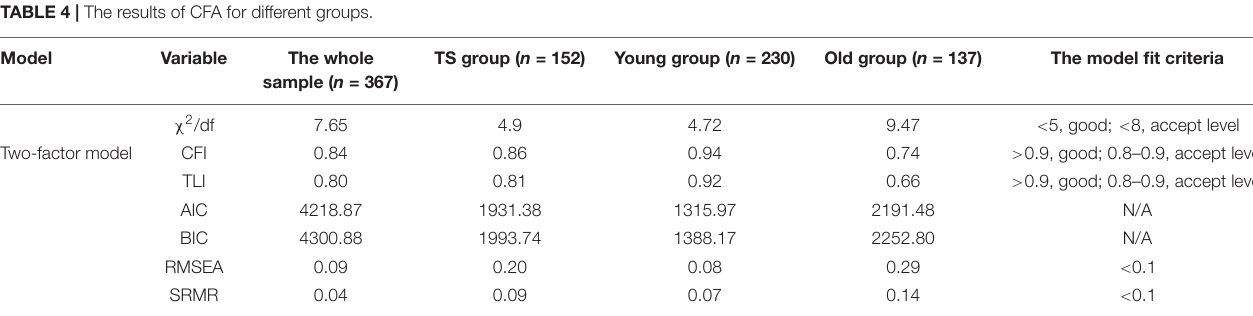
FIGURE 2 | Confirmatory factor analysis of CY-BOCS in the younger and older adolescent groups. CY-BOCS, Children’s Yale–Brown Obsessive–Compulsive Scale. TABLE 4 | The results of CFA for different